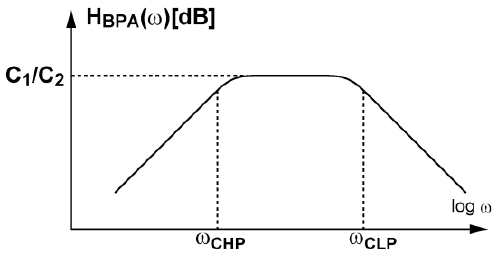
Figure 7. Frequency Response of Bandpass